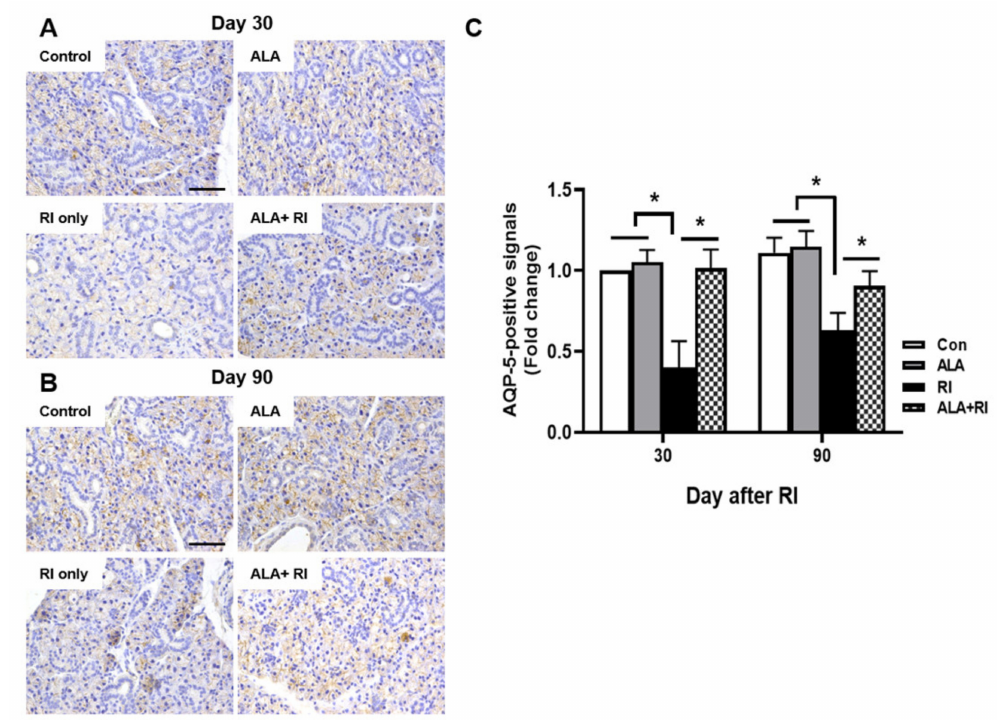
Figure 4. Aquaporin 5 (AQP-5) expression in the SGs of mice that underwent RI therapy. Tissues were dissected from each mouse, fixed in 4% paraformaldehyde, and cut into sections 5 µ m thick. Diaminobenzidine (DAB) staining (brown) of AQP-5 to identify salivary function. Representative sections immunohistochemically stained for AQP-5 expression in the acinar cells of the control and ALA only groups. AQP-5 expression level was significantly higher in the RI + ALA group than the RI only group. ( A , C ) 30 days post-RI therapy; ( B , C ) 90 days post-RI therapy. Data are means ± SD. * P < 0.05 compared to the indicated groups. Scale bars: 100 µ